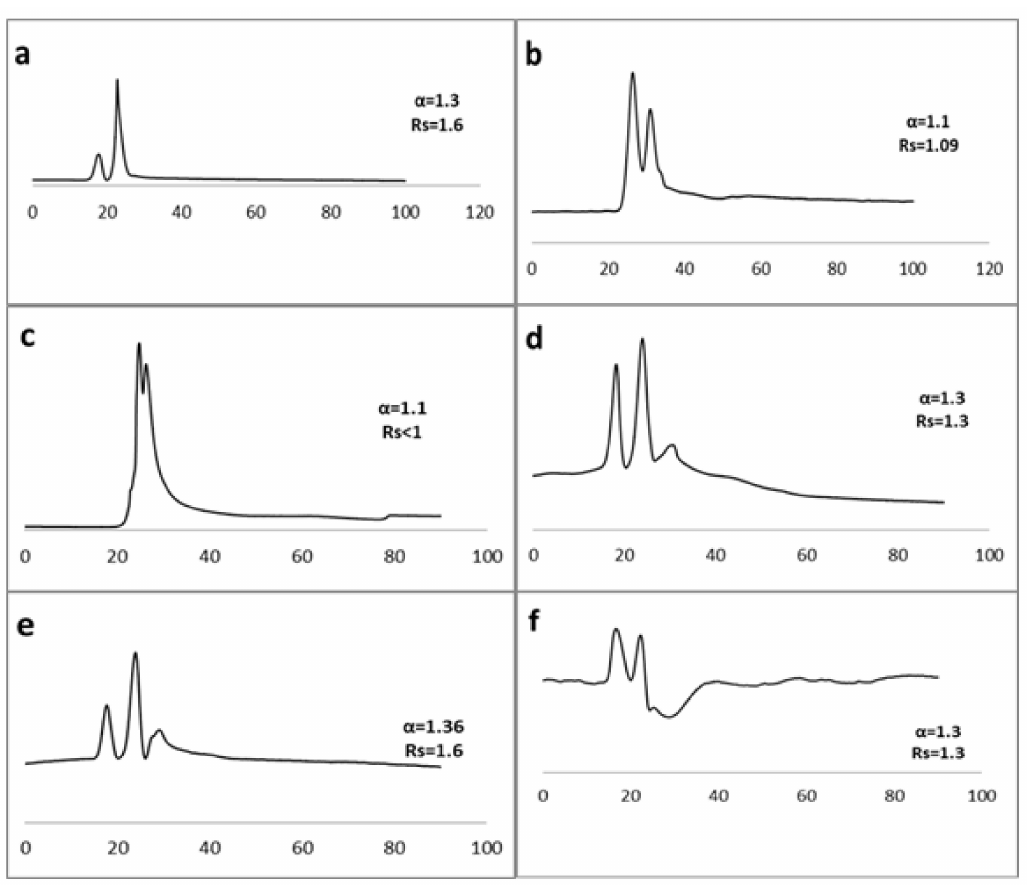
Figure 7. Enantioselective nano-lc separation of racemic Acebutolol ( a ) (Mobile phase: ACN/water 10:90 v/v ,), pindolol ( b ) (Mobile phase: ACN/water 20:80 v/v ,), Metoprolol ( c ), pindolol ( d ), 1-Indanol ( e ), and Thalidomide ( f ) (Mobile phase: ACN/water 5:95 v/v on D3 capillary column (150 µ m ID, 25 cm length)). UV: 219 nm, flow rate: 1 µ